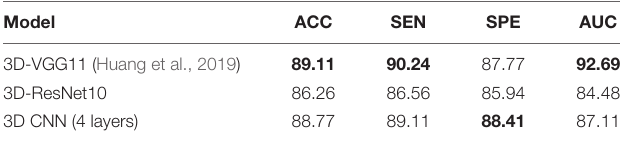
TABLE 5 | Diagnosis results (%). MRI+PET (Real data)